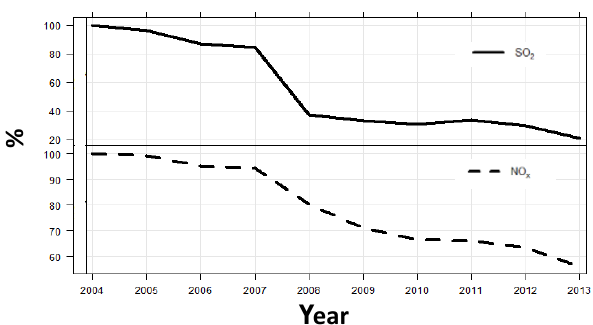
Figure 8. Spanish national emission of SO 2 and NO x (normalized to year